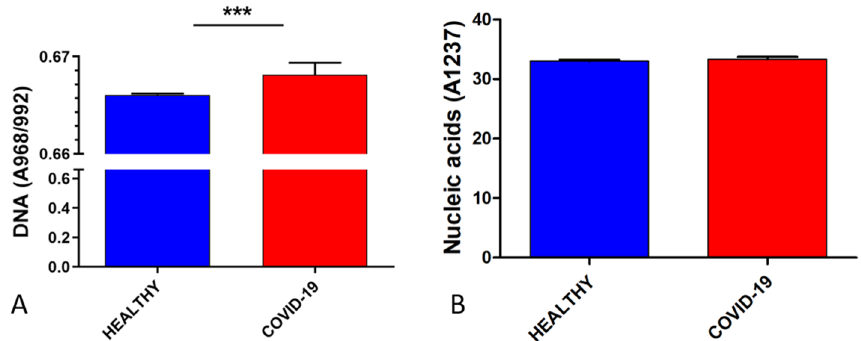
Figure 5. Comparison of the DNA and nucleic acids content between healthy and COVID-19 groups. ( A ) DNA content, the COVID-19 group exhibited a higher DNA content (0.6681) compared to the healthy group (0.6660). ( B ) Nucleic acids content, the COVID-19 group showed a higher nucleic acids content (33.30) relative to the healthy group (33.00). Means of DNA and nucleic acids content with error bars representing the standard deviation are depicted, ***p <